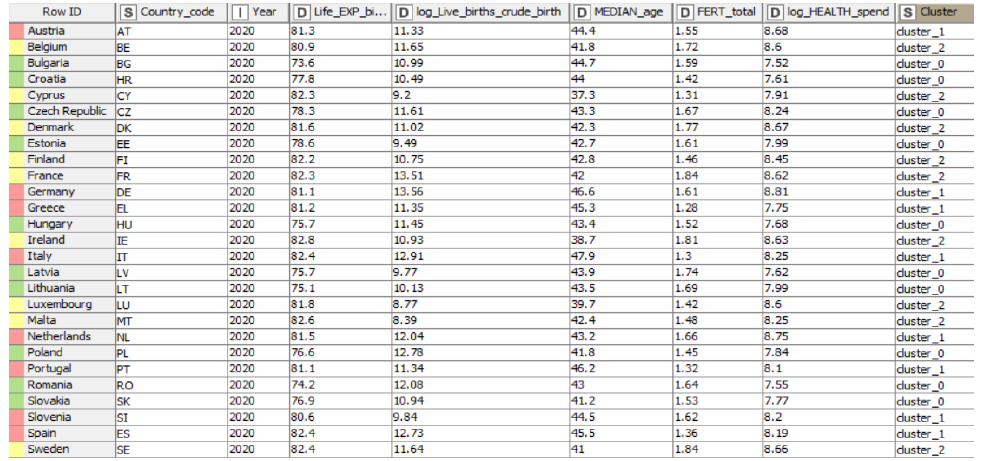
Figure 8. Countries displayed by clusters, based on health indicators. Source: authors’ compilation in KNIME analytics platform.